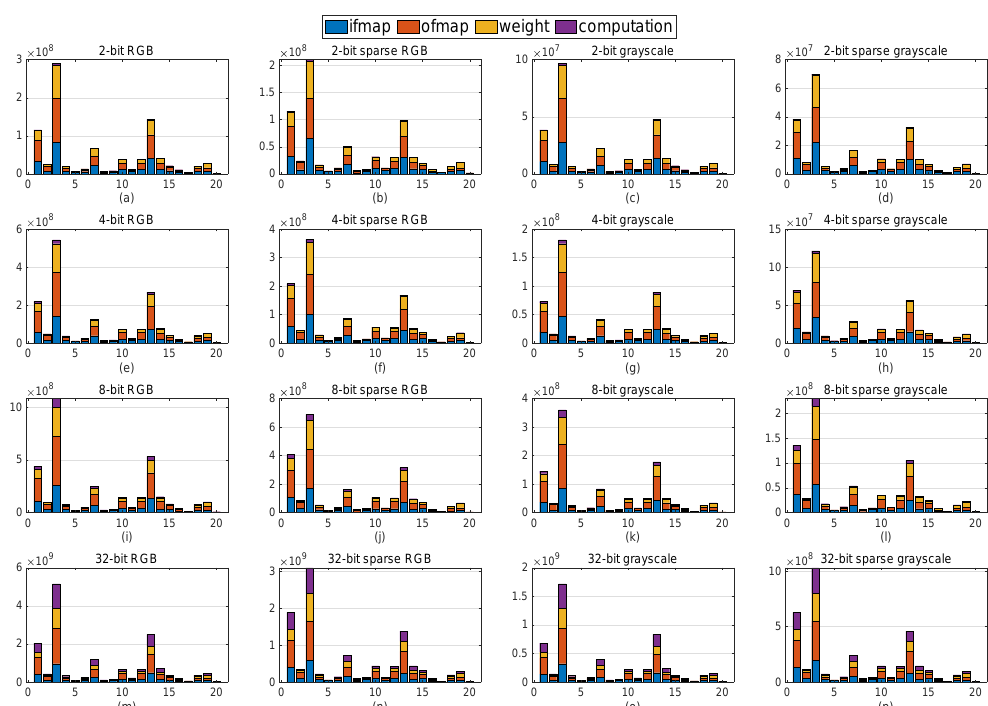
Figure 3. Energy consumption for MHIST dataset, where each row and each column leveraged the same bit-width (e.g., ( a – d )) and identical ResNet20 implementations (e.g., ( a – m )),